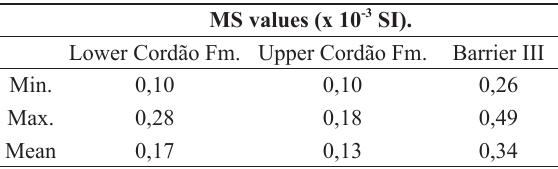
Magnetic susceptibility values from the loess and the Barrier III in the southern CPRS MS values (x 10 -3 SI).